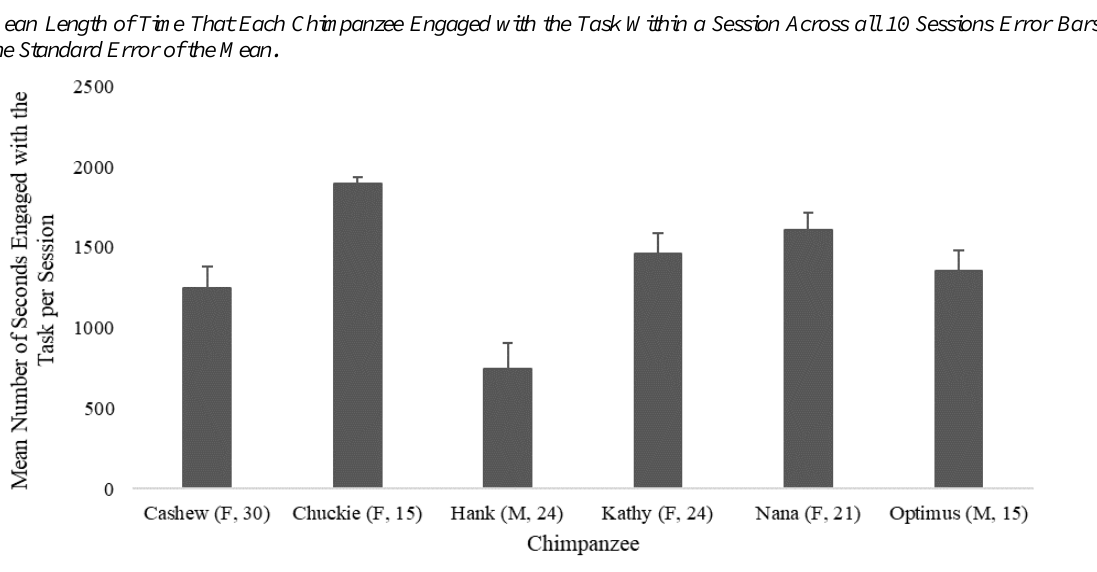
All Tool Modification Behaviors Made by the Chimpanzees Across all 10 Sessions Type of Modification (followed by tool type)